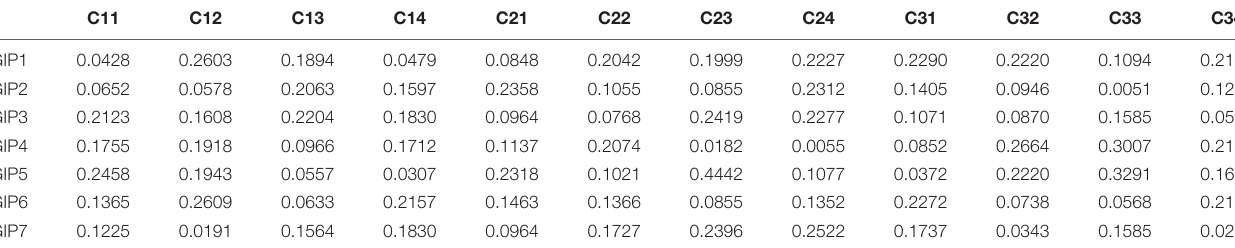
TABLE 7 | The merged matrix based on the matrices of defuzzification.